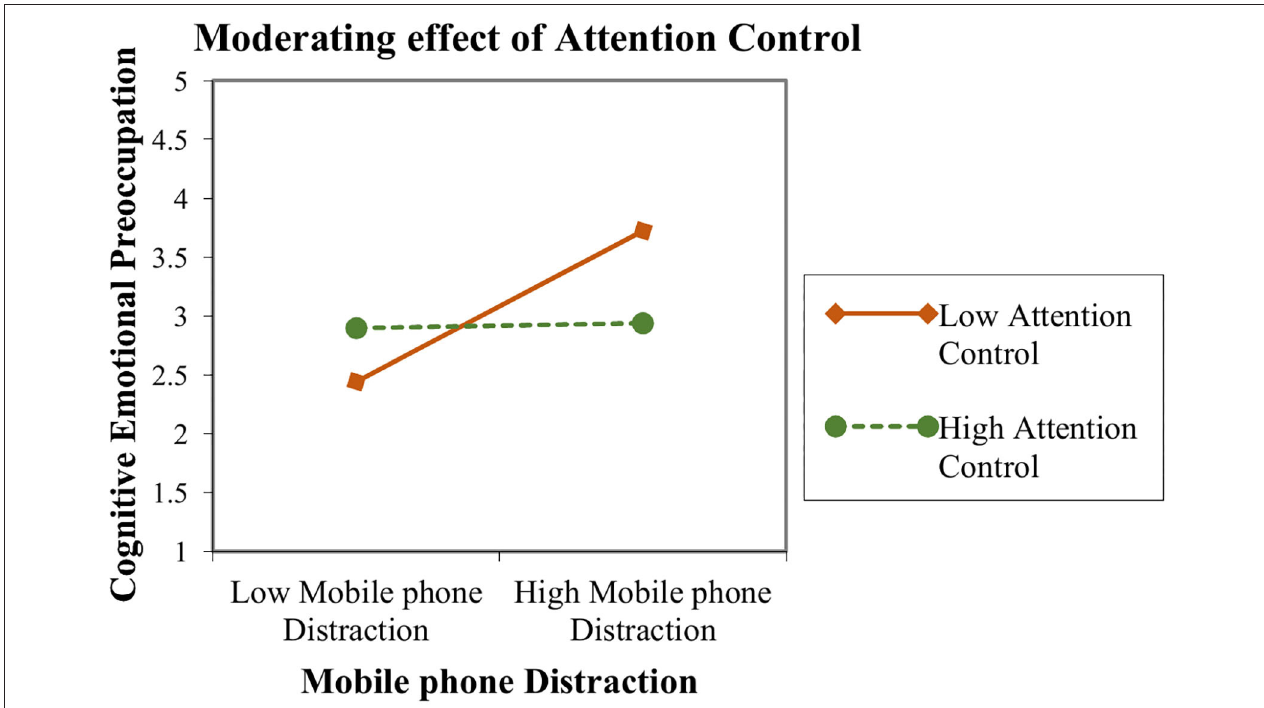
FIGURE 3 | Moderating effect of attention control between the relationship of mobile phone distraction and cognitive emotional pre-occupation.